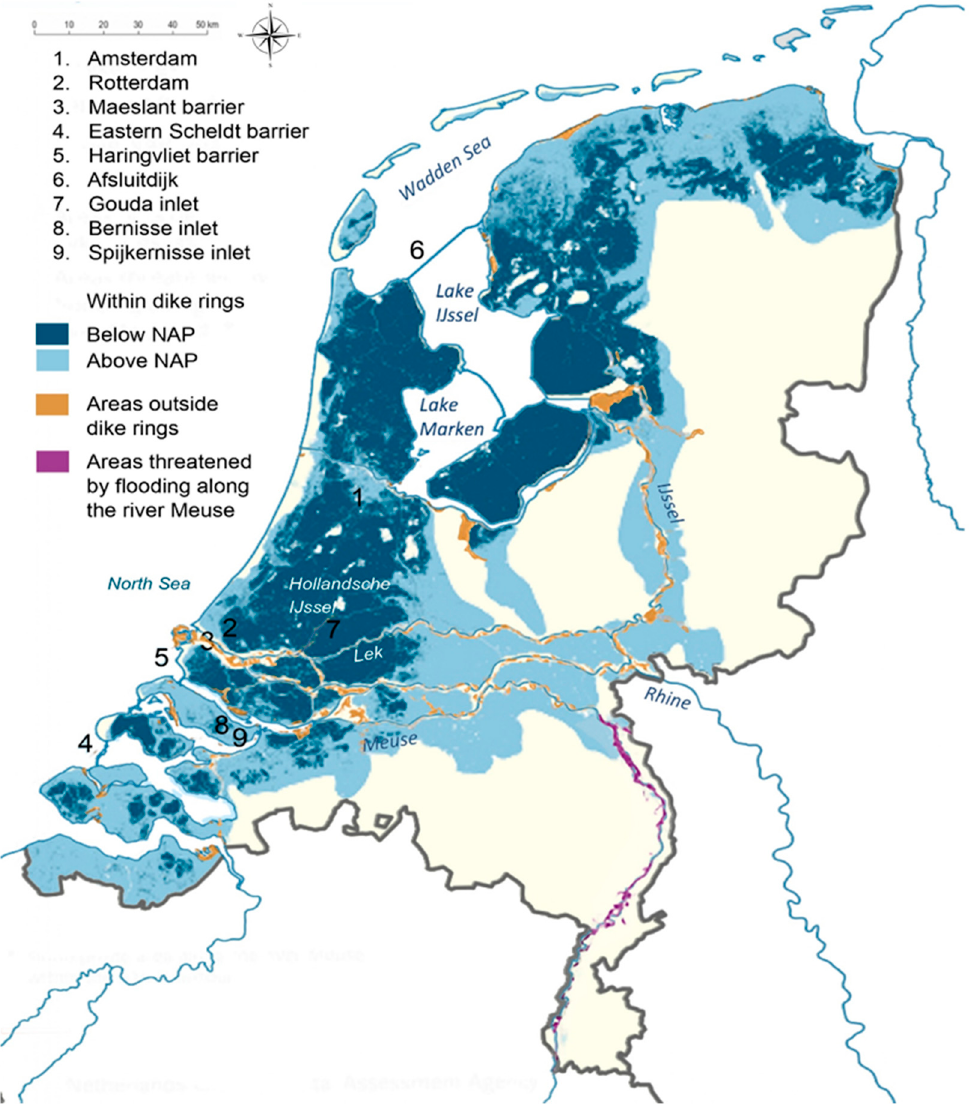
Figure 1. Flood-prone areas in the Netherlands, present situation. NAP is ordnance datum, which is about mean sea level. Dike rings are areas protected by flood defenses. (Reprinted with permission from Haasnoot et al. 2020 [10]).